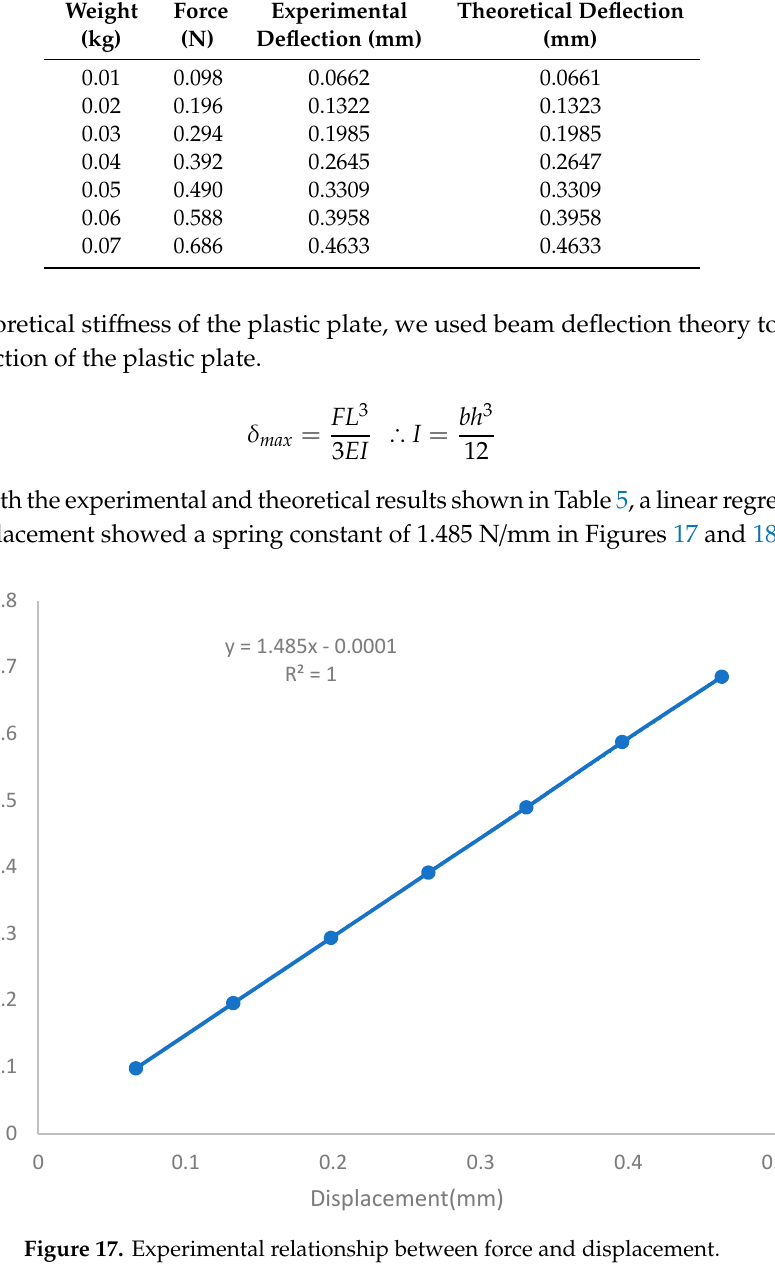
Figure 17. Experimental relationship between force and displacement.